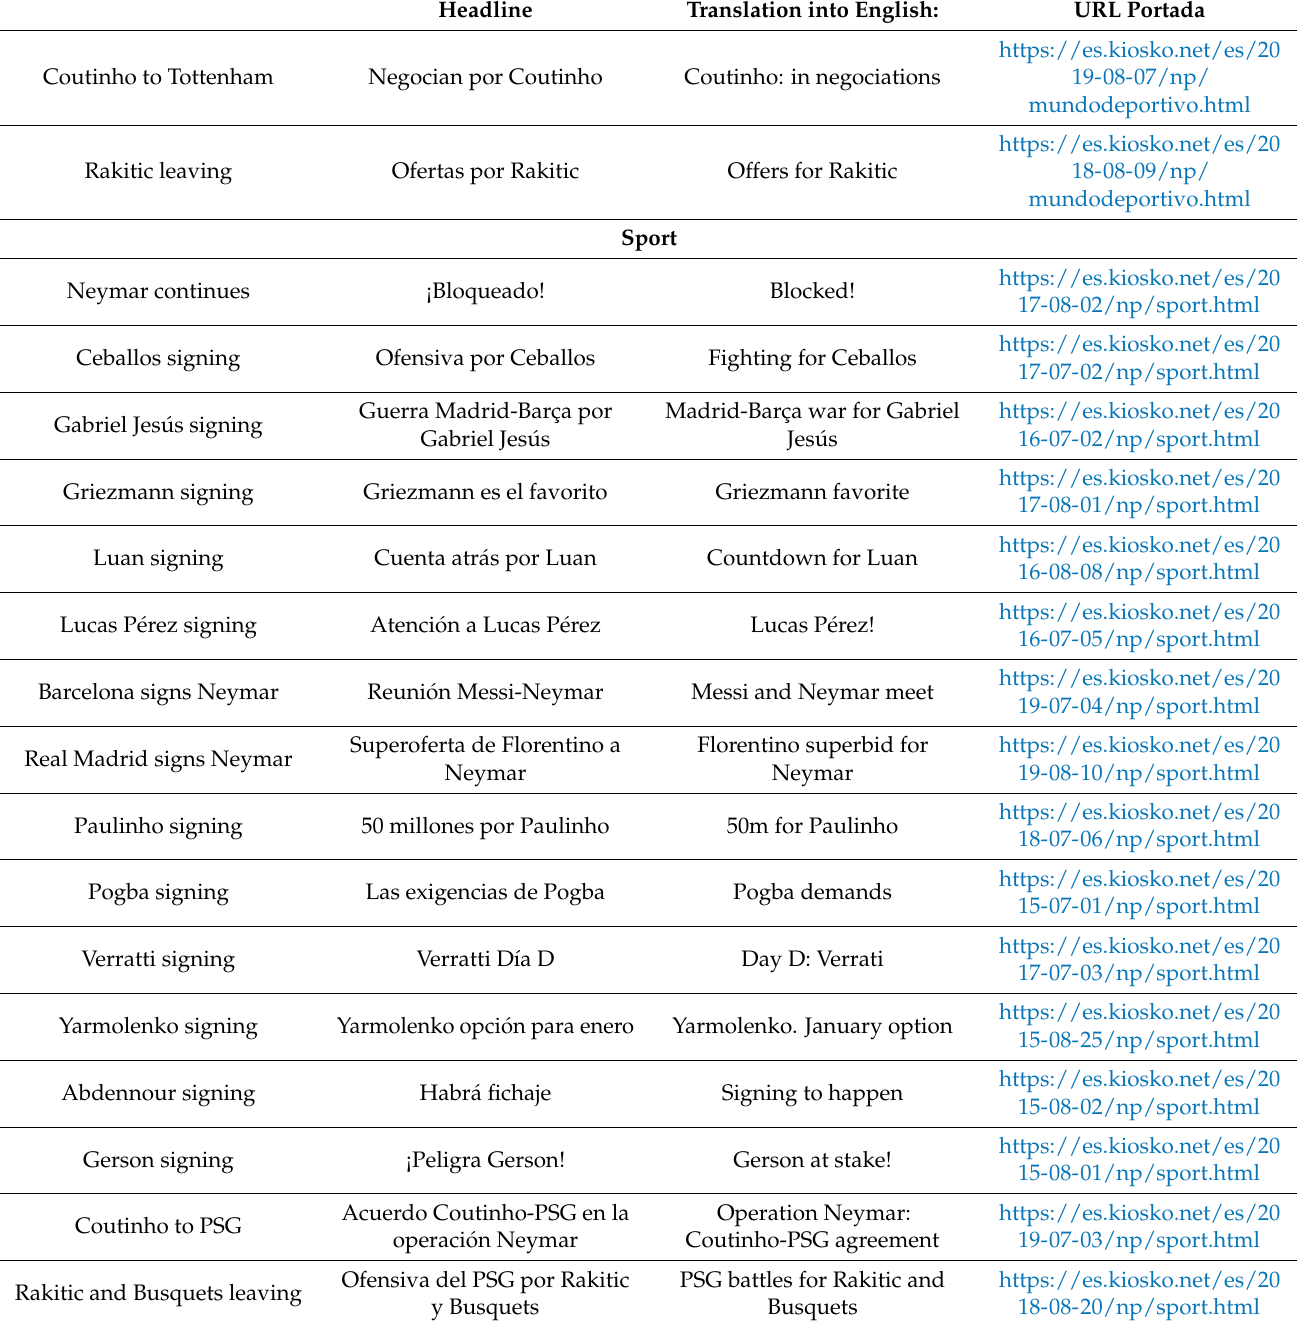
Table 5. Cont . Headline Translation into